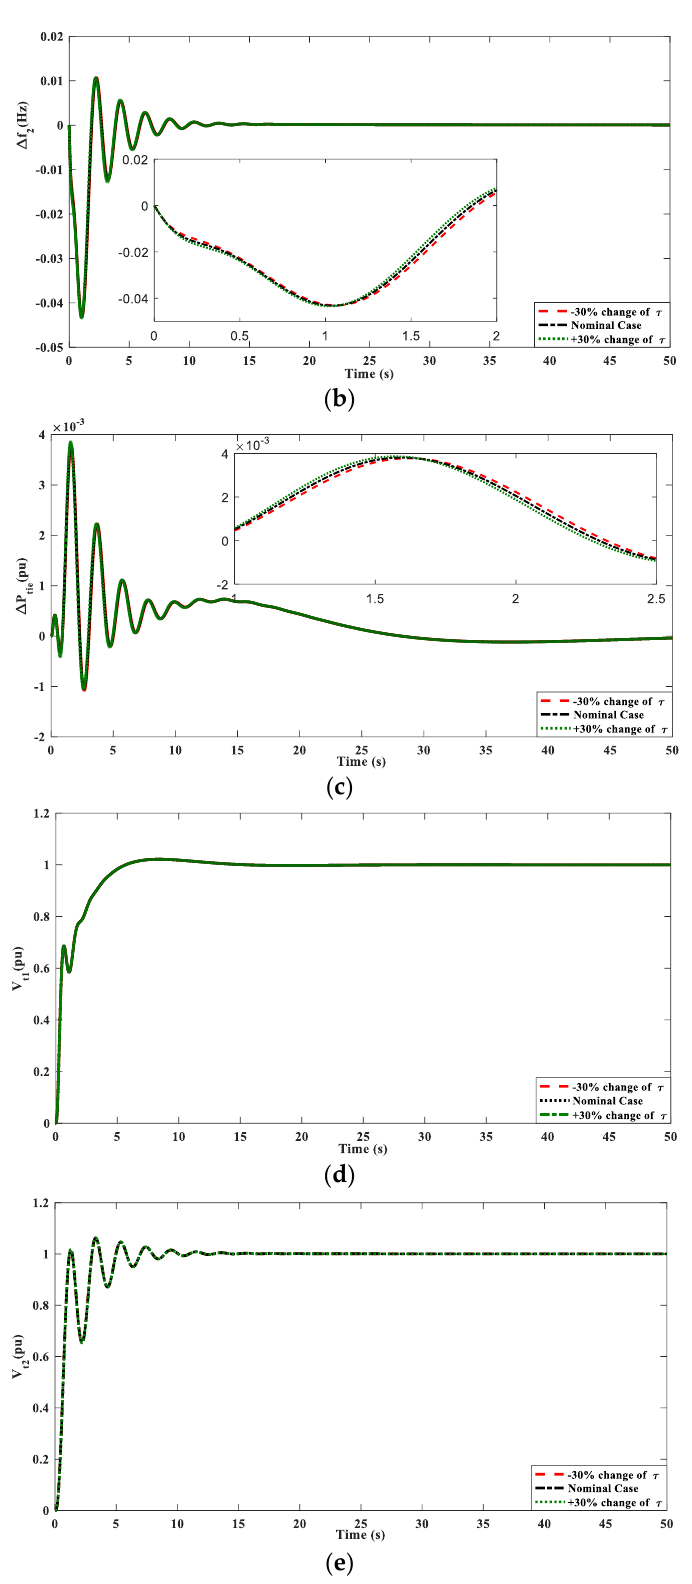
Figure 7. Dynamic responses with insensitive of turbine time constant ( τ ) of RTPP and GTPP of both the areas: ( a ) ∆ f 1 ; ( b ) ∆ f 2 ; ( c ) ∆ P tie ; ( d ) V t1 ; ( e ) V t2 .